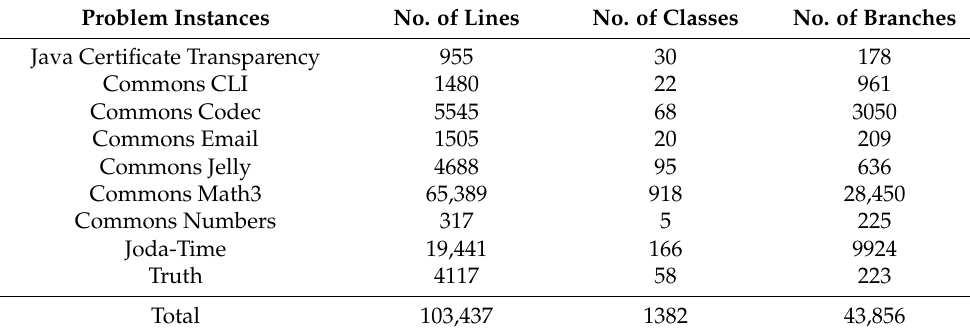
Table 2. Details of open-source Google and Apache projects. Note: the second column lists the number of non-commenting source lines of code reported by JavaNCSS (http://www.kclee.de/ clemens/java/javancss/ (accessed on 10 December 2020)). The fourth column lists the number of branches reported by